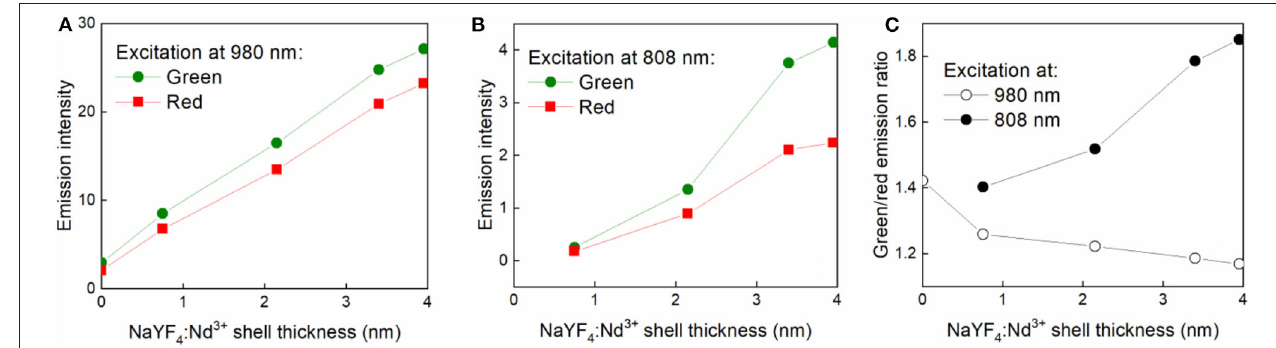
FIGURE 5 | Dependence of green (541nm) and red (655nm) emission intensity of nanoparticles (1 mg/ml) in hexane/water emulsion stabilized with Igepal CO-520 on NaYF